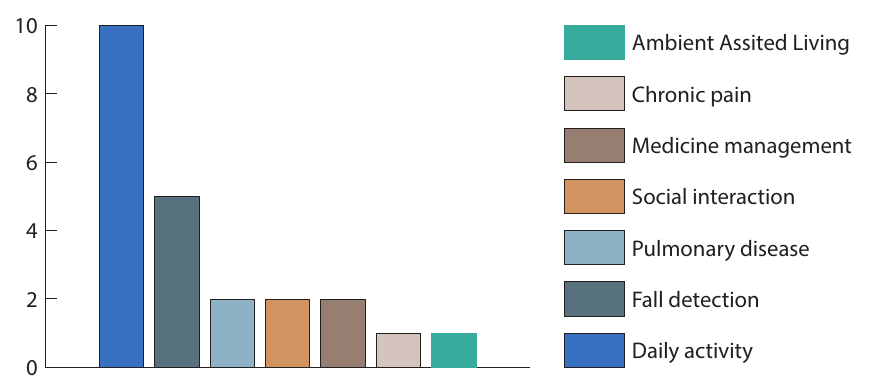
Figure 3. Number of publications for each of the targeted